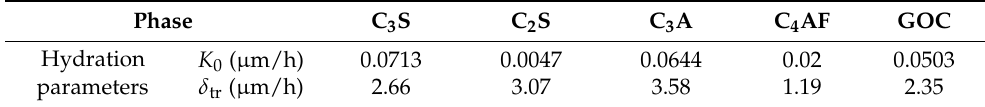
Table 3. The hydration parameters of